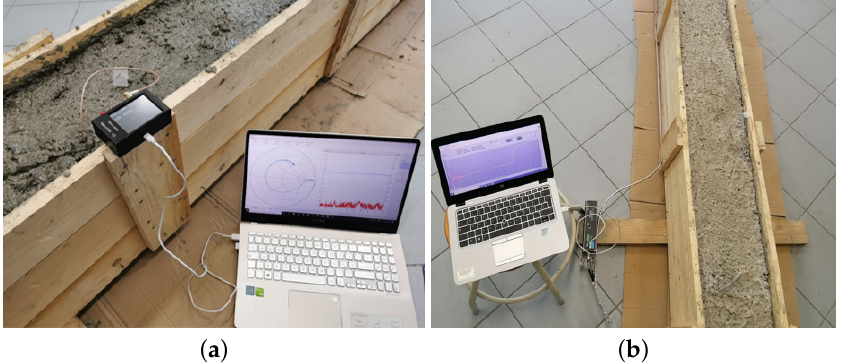
Figure 3. Experimental setup for measurements on the concrete beam: ( a ) nanoVNA with PCP for FDR measurements; ( b ) TDR with d-SE for TDR